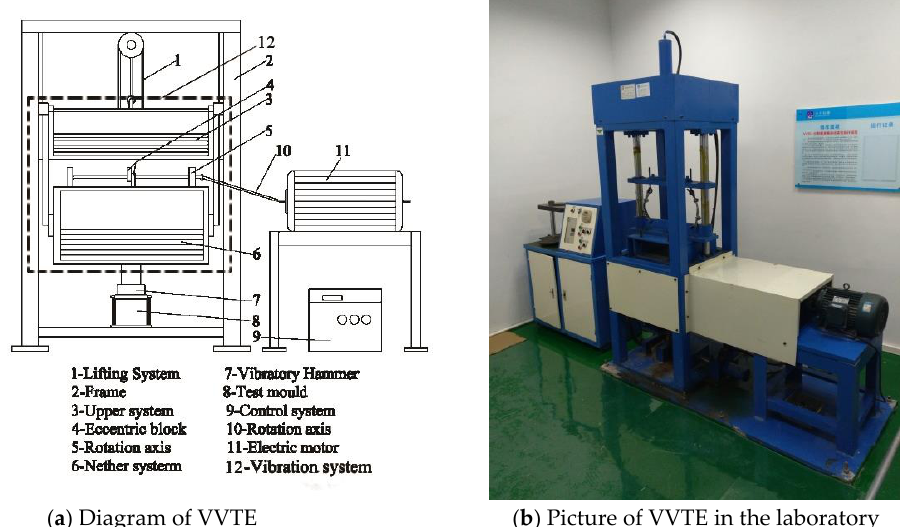
Figure 2. Structure of VVTE.